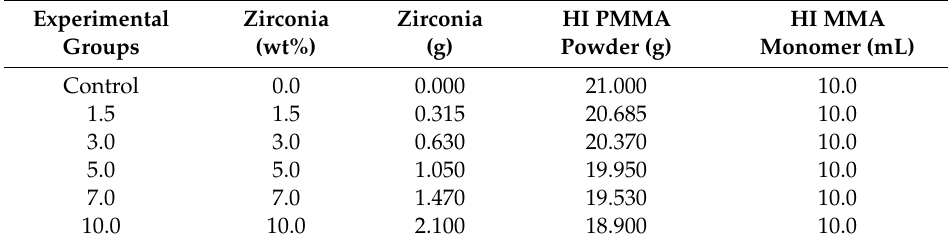
Table 1. Weight percent zirconia in combination with acrylic resin powder as well as monomer content of the specimen groups. HI: High impact; PMMA: Poly-methyl methacrylate; MMA: methyl methacrylate.